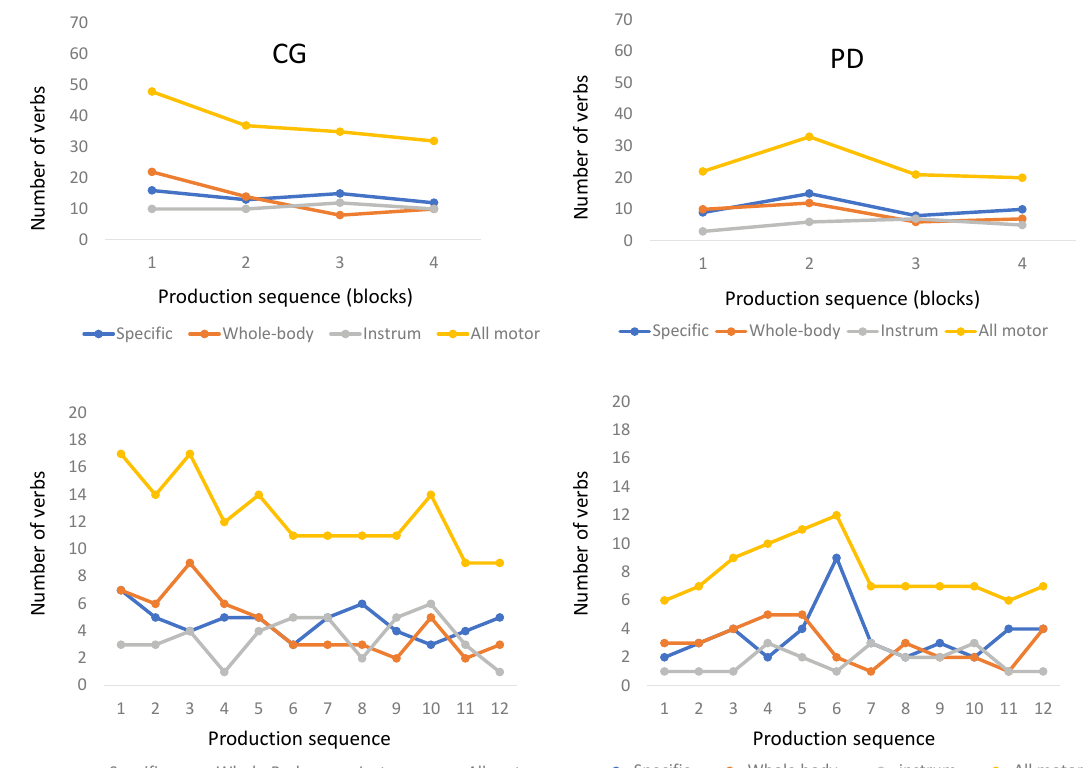
Figure 1. Sequential performance. CG: control group; PDG: Parkinson’s disease